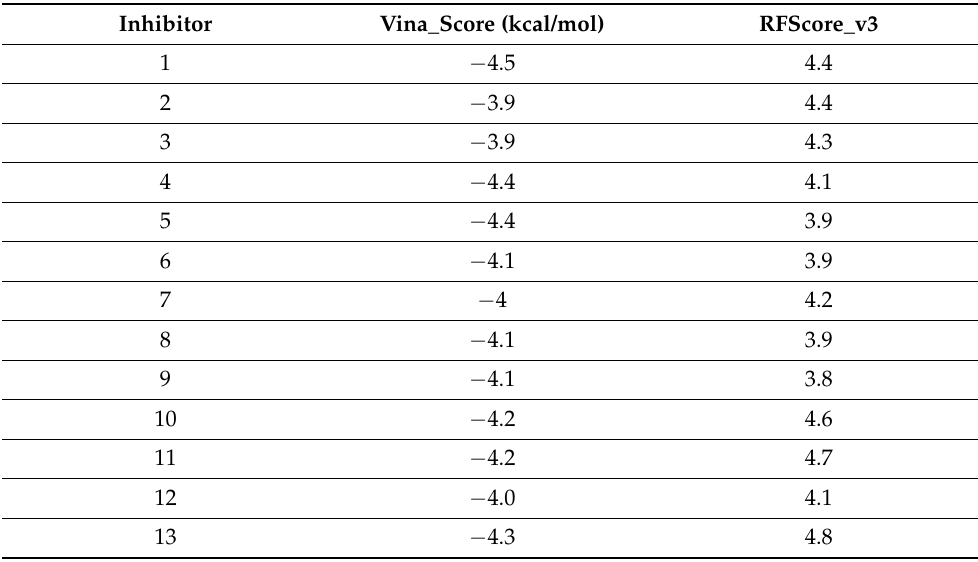
Table 1. Results from molecular docking of inhibitors and Lmr-47